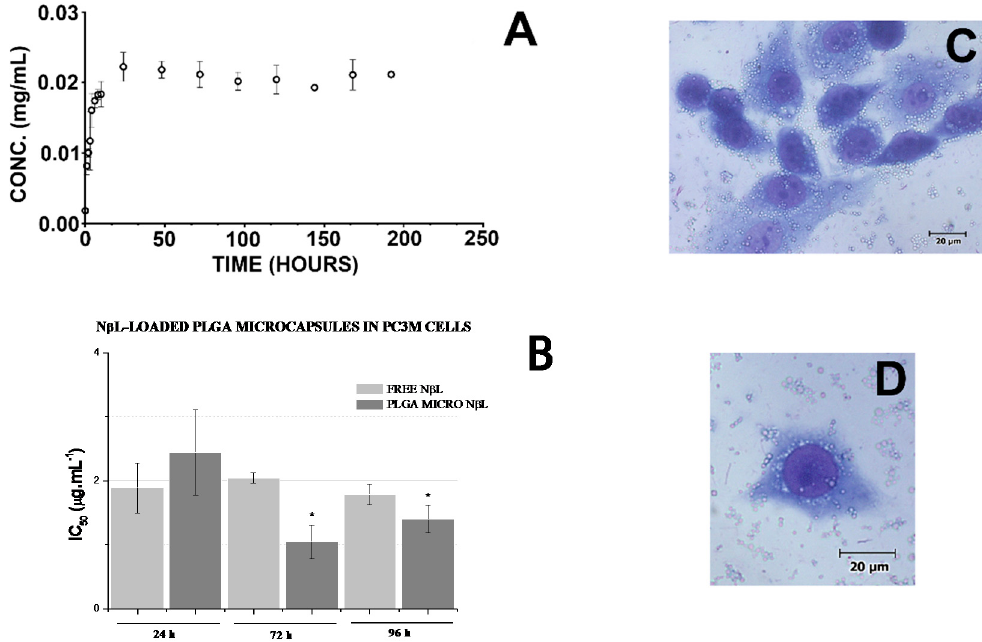
Figure 4. Drug release and in vitro assays. ( A ) Release profile of N β L from PLGA microcapsules under physiological conditions at 37 °C in PBS buffer (pH 7.4) ( n = 3). Data are presented as mean values ± S.E.M. (standard error of the mean); ( B ) IC 50 values for free and encapsulated N β L after 24, 72 and 96 h incubation with PC3M human prostate cancer cells. Data are presented as mean values ± S.E.M. from two independent experiments performed in duplicate ( n = 4). * Significant difference from the PLGA micro N β L (24 h) group ( p < 0.05) according to ANOVA Tukey’s test; ( C , D ) Microscopic analysis of hematoxylin/eosin-stained PC3M cells after 1 h of treatment with PLGA microcapsules containing N β L. The cells were analyzed by light microscopy (400×).